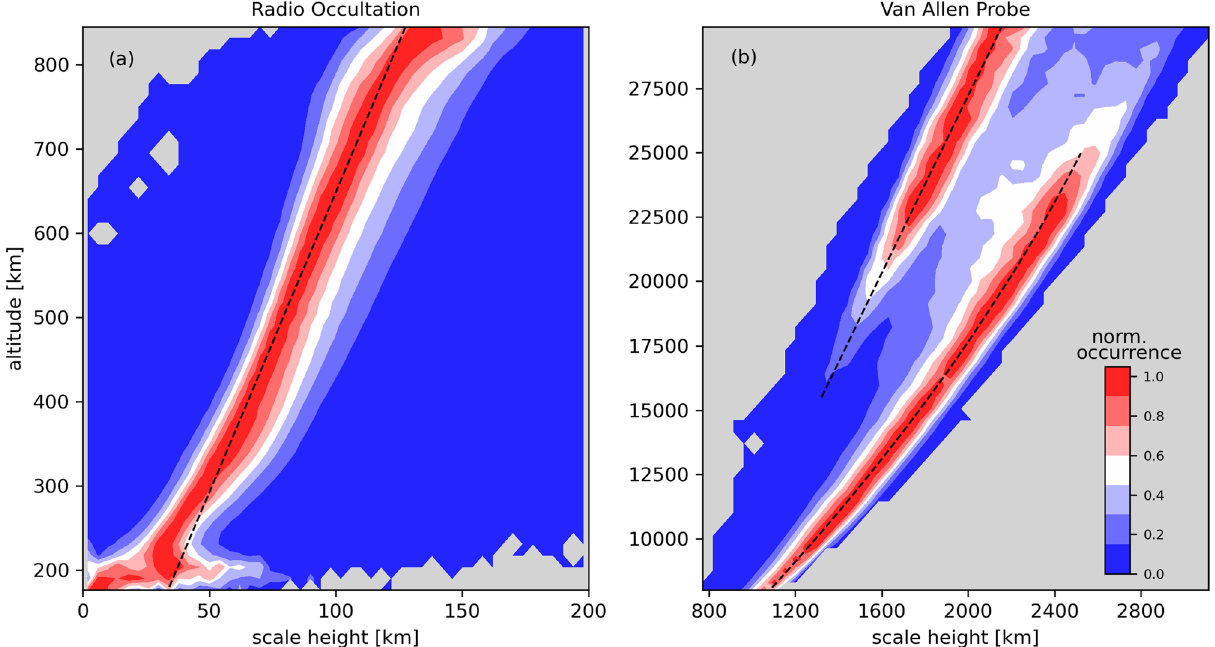
Figure 1. Altitude distribution of scale height values derived from: ( a ) the COSMIC RO measurements binned with 4 km in scale height and 13 km in altitude during the first 60 days of 2014 and ( b ) Van Allen Probe data using the entire dataset of 2014 binned with 44 km in scale height and 436 km in altitude. The color bar shows the normalized occurrence of the most predominant patterns of the dataset. Black dashed lines represent a linear fit on figures a) and b) and quadratic fit on figure